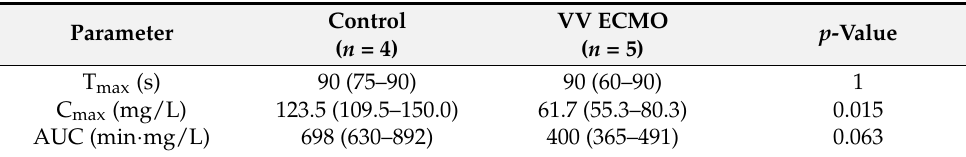
Table 4. Individual pharmacokinetic parameters estimated by PK modeling (T max , C max and AUC). Results are expressed as median and interquartile range. Significant difference was observed for maximum concentration (C max ) between control and ECMO groups.